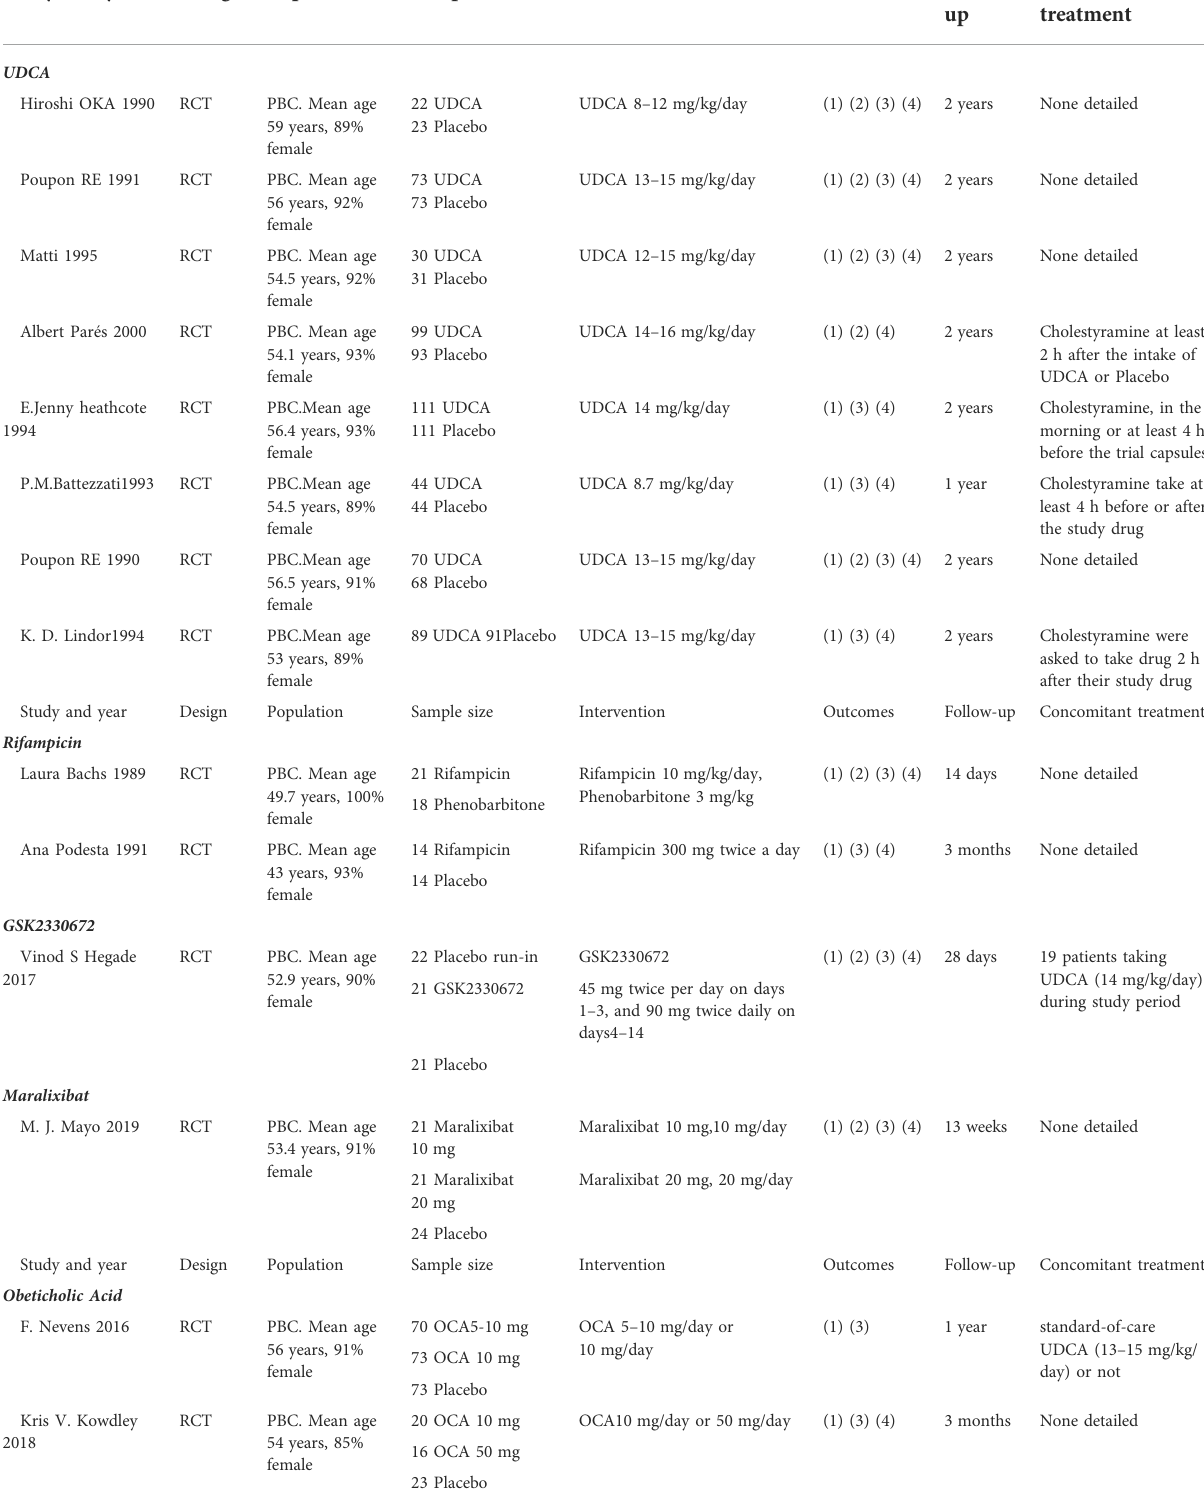
TABLE 1 Basic characteristics of 23 included